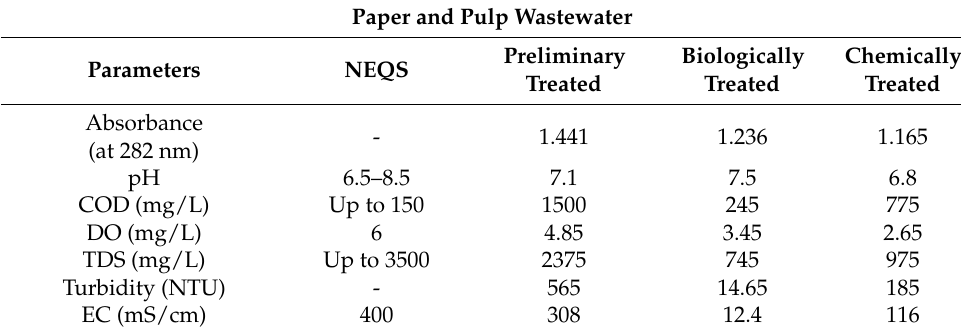
Table 1. Physico-chemical parameters of wastewater used for the present study. Paper and Pulp